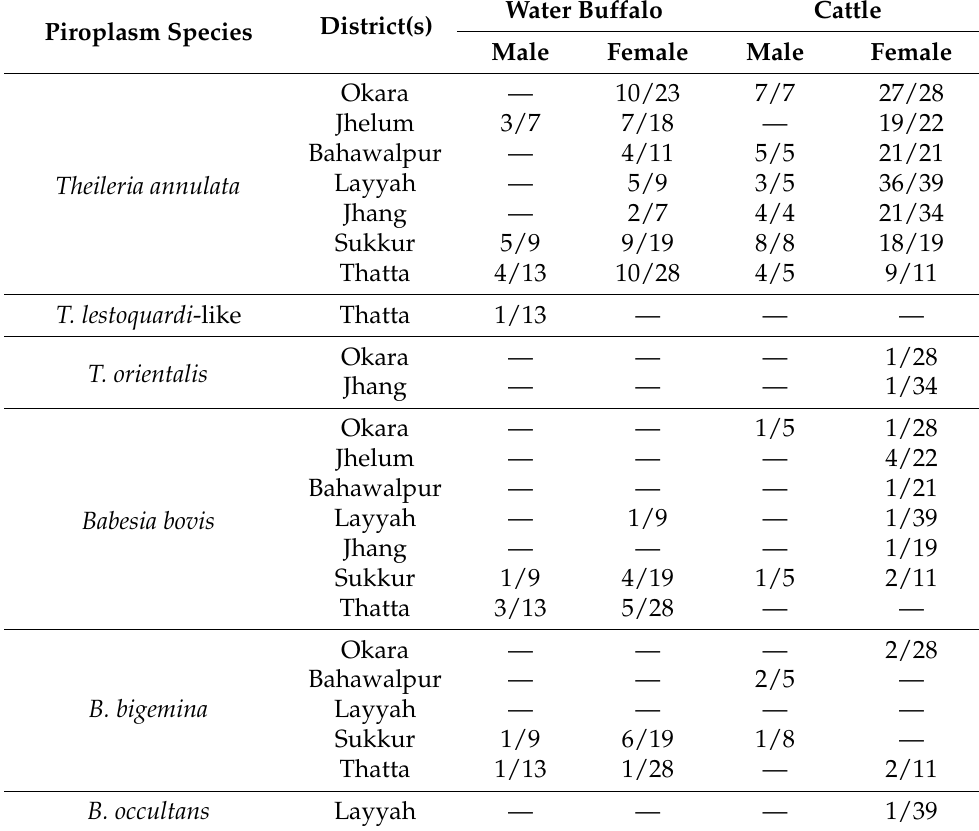
Table 1. Piroplasm species detected in bovines from seven districts of Punjab and Sindh, Pakistan. Piroplasm